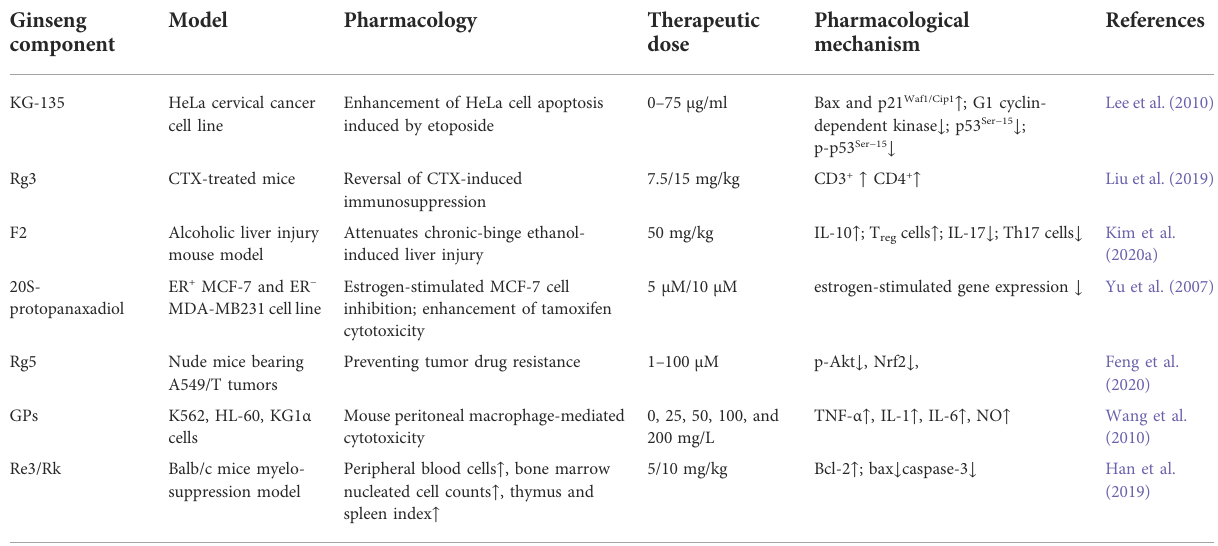
TABLE 1 The effects of ginseng components on